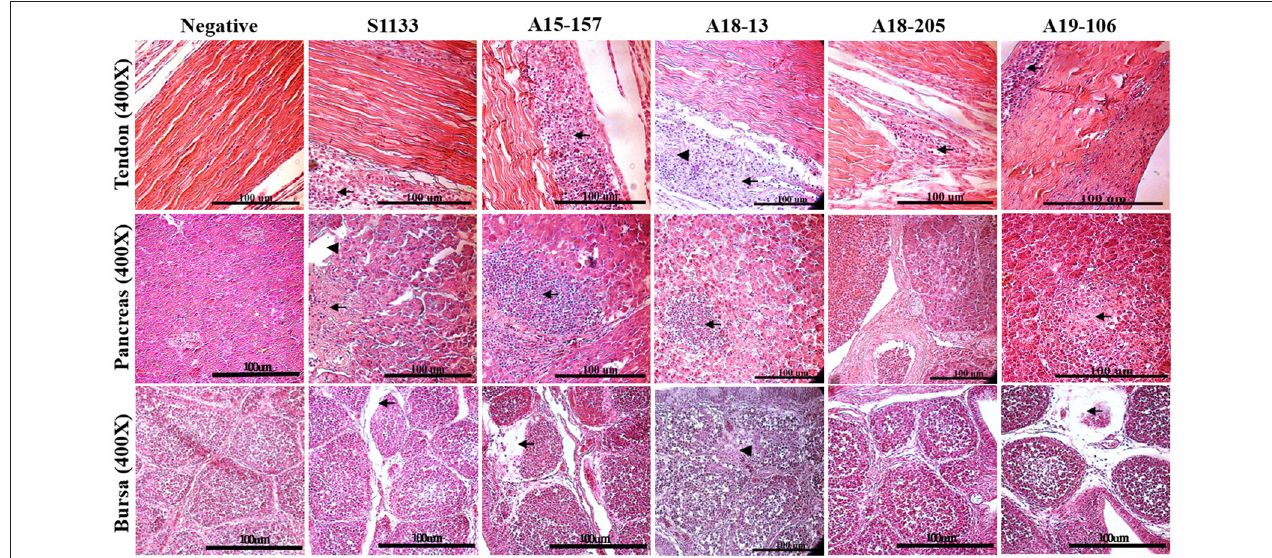
FIGURE 3 | Histopathological changes in chickens infected with ARVs. Pathological changes including subsynovial lymphocytic infiltration (arrow) and fibrosis (arrowheads) were found in the tendon section; extensive inflammatory cells (arrows), dilated acini (arrowheads), and hemorrhage were found in the pancreas section. Lymphocyte depletion in the bursa section (arrow) and heterophilic granulocyte infiltration in the cortex (arrowheads) were found in those infected with ARV but not in the negative control group